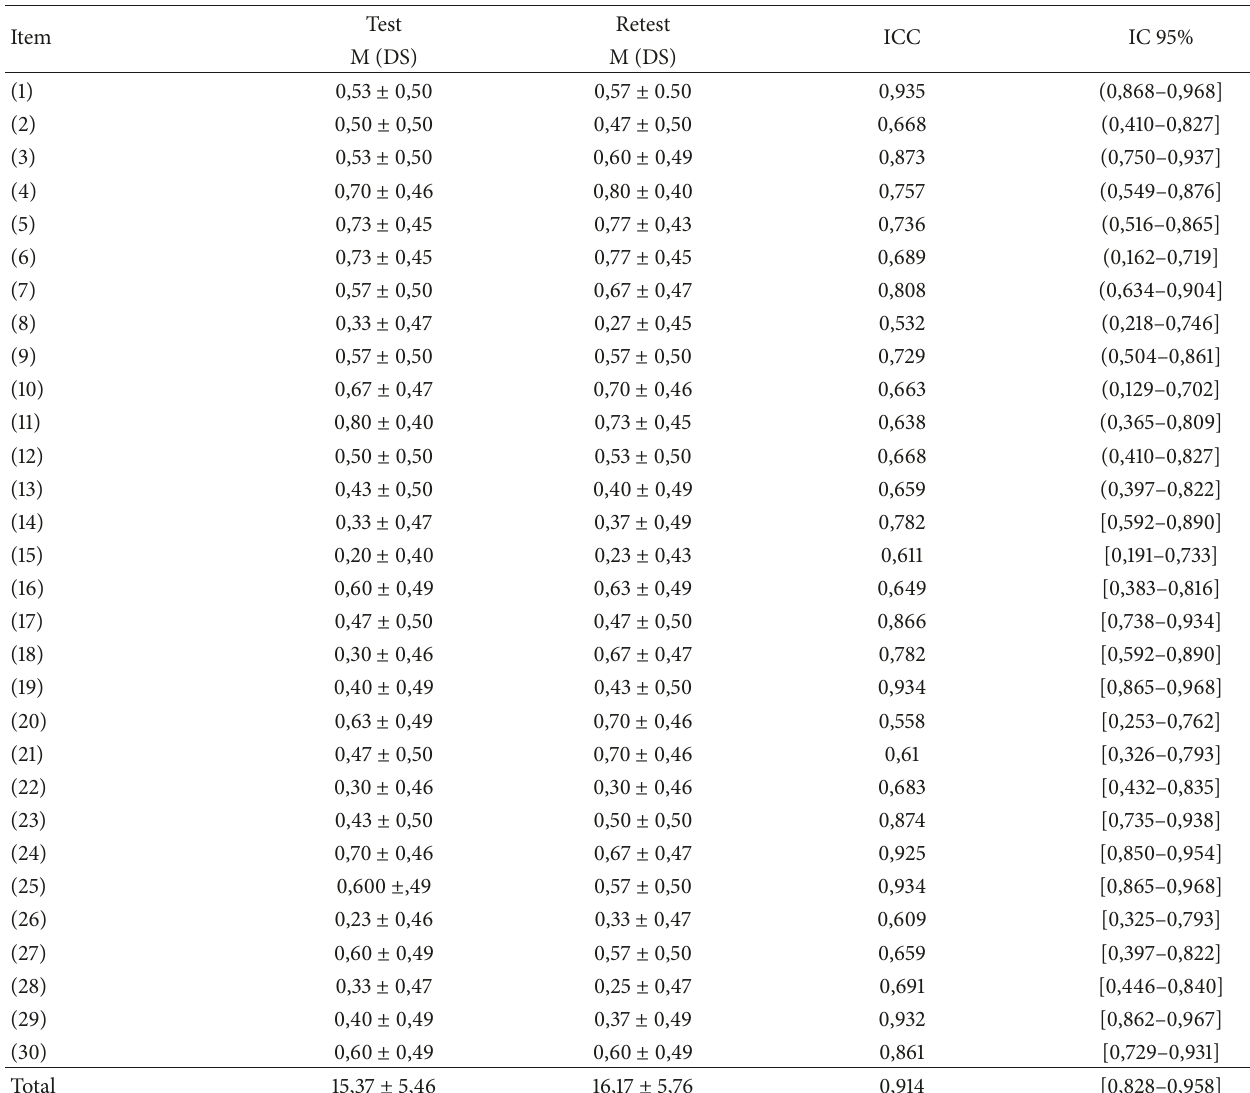
Table 2: Test-retest